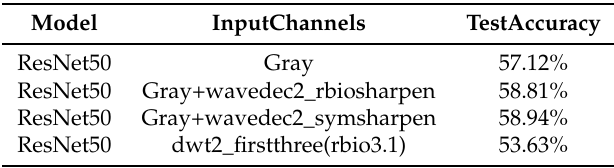
Table 4. The results of the RAF Compound test set based on different input channels of ResNet50 fine tuned on FER2013.